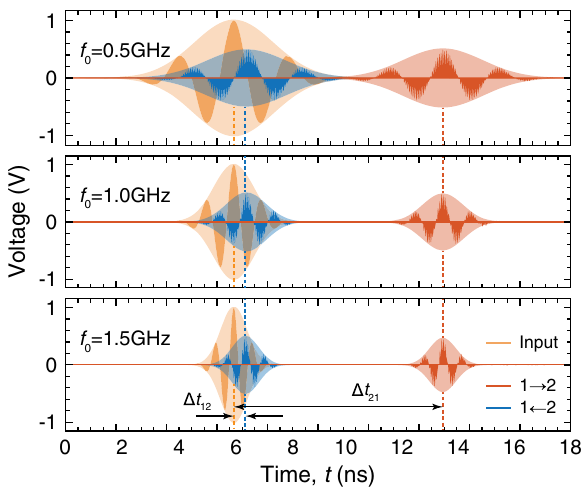
FIG. 6. Propagation of pulses with center frequency f 0 ¼ 0 . 5 , 1.0, and 1.5 GHz through an eight-unit-cell cascaded commutated network with N ¼ 16 , C ¼ 0 . 68 pF, L ¼ 0 . 75 nH, and switch- = 16 . The FWHM duration of each input ing delay Δ T ¼ 15 T ffiffiffiffiffiffiffiffiffiffiffi p s 2 ln 2 f − 1 0 . For pulses sent from port 1 to pulse (yellow lines) is 2 port 2 (red lines), the accumulated time delay is Δ t 21 ¼ 8 Δ T . For pulses sent from port 2 to port 1 (blue lines), the time delay is Δ t ¼ 8 T − Δ t 12 21 . The width of the forward and reverse pulses s remains unchanged due to nearly zero group velocity dispersion. The analysis is performed using Keysight ADS (time-domain analysis) [51].